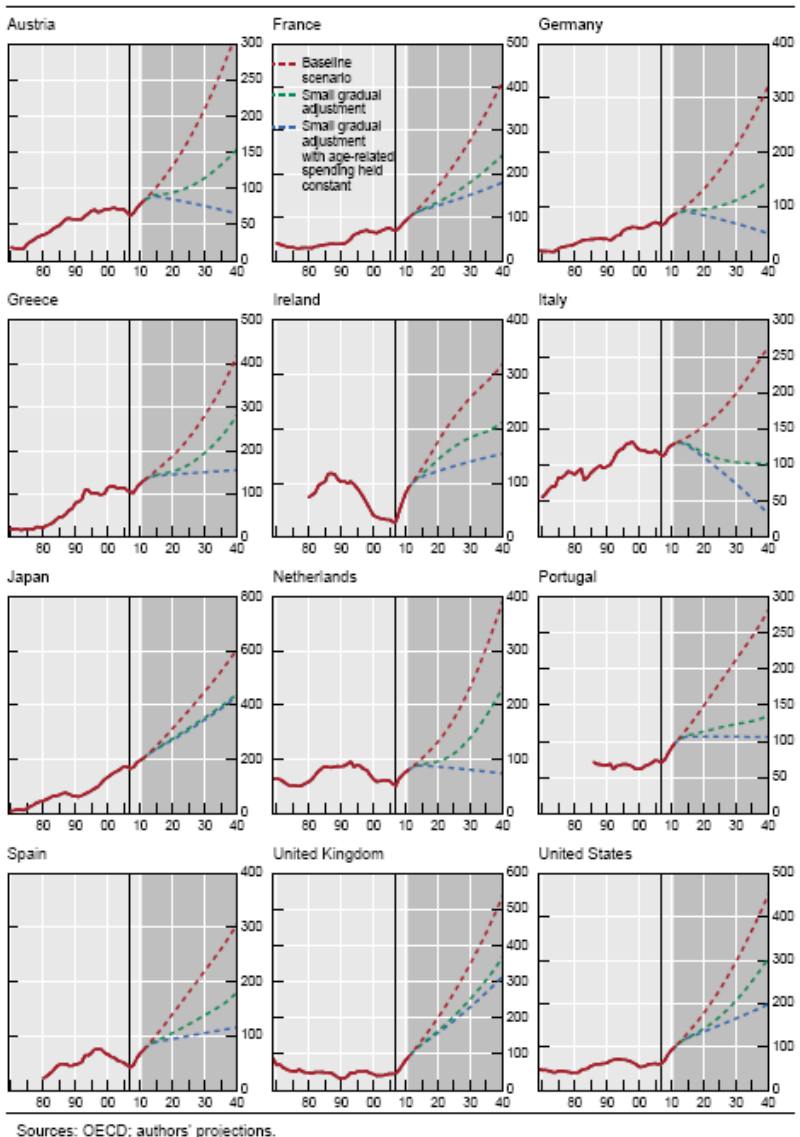
Figure 17. The projection of debt/GDP in a dozen of major industrial economies following three different scenarios, source: BIS Working Papers No 300